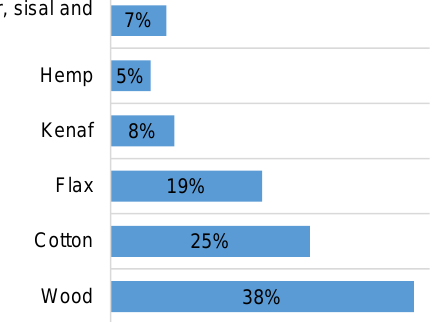
Figure 7. Use of Wood and Natural Fibres for Composites in European automotive industry in 2012 (total volume: 80,000 tons, adapted from: [95]).